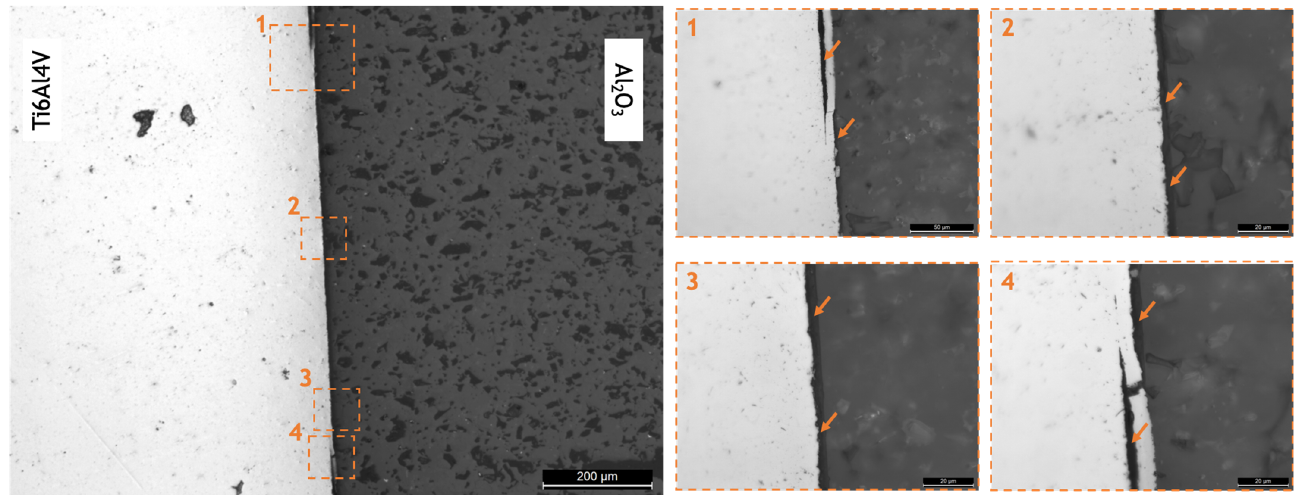
Figure 11. OM images of the joint processed at 950 °C for 60 min using a Ti freestanding thin foil as interlayer.